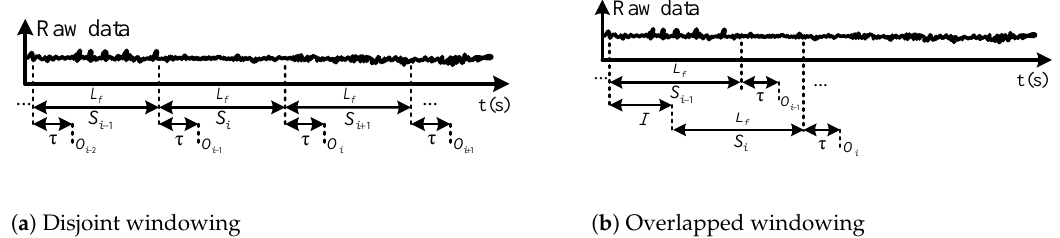
Figure 4. Data windowing. S i represents the i -th data segment, L f is the frame length, τ is the required processing time, I is the increment length for overlapped windowing, and O i is the detected gait mode corresponding to frame S i